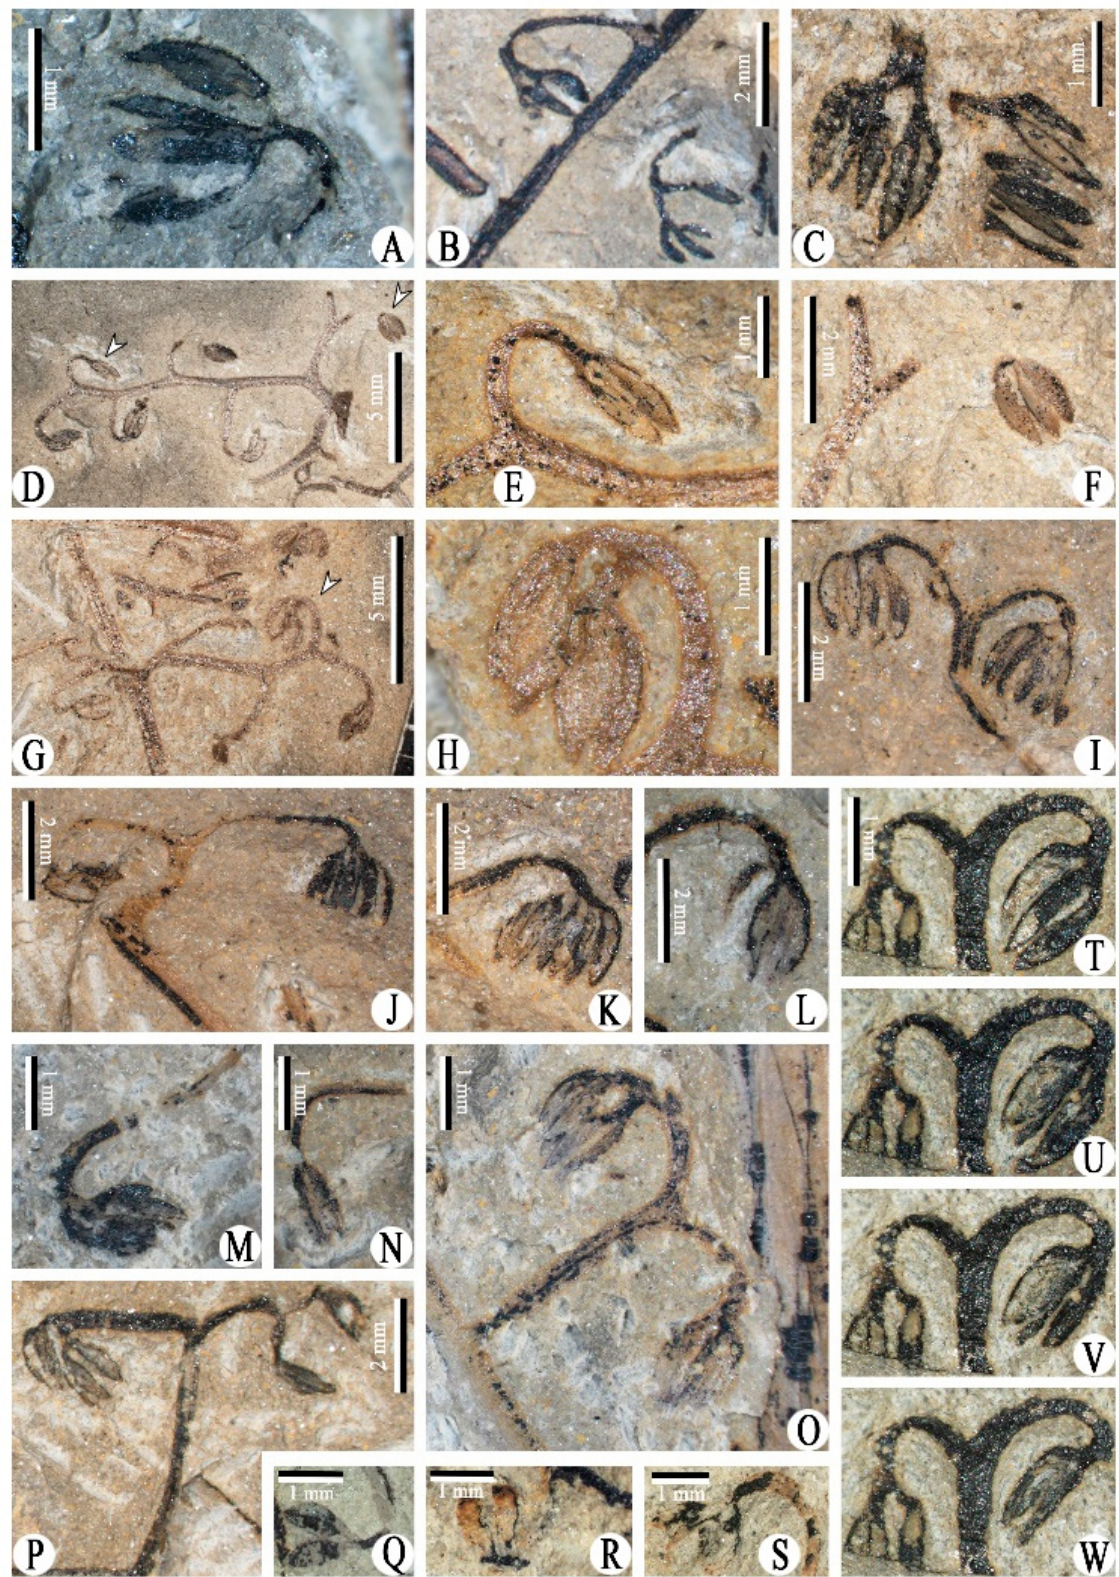
Figure 5. Morphology of Xinhangia spina gen. et sp. nov. from Guangde City, Anhui Province, China. ( A ) One single sporangial cluster bearing two pairs of elongate sporangia enlarged from Figure 1F (arrow 1). ( B ) Enlargement of Figure 4A (arrow) showing one fertile organ arranged on secondary branch. ( C ) Two clusters of sporangia enlarged from Figure 4B (arrow). ( D , G ) Fertile secondary